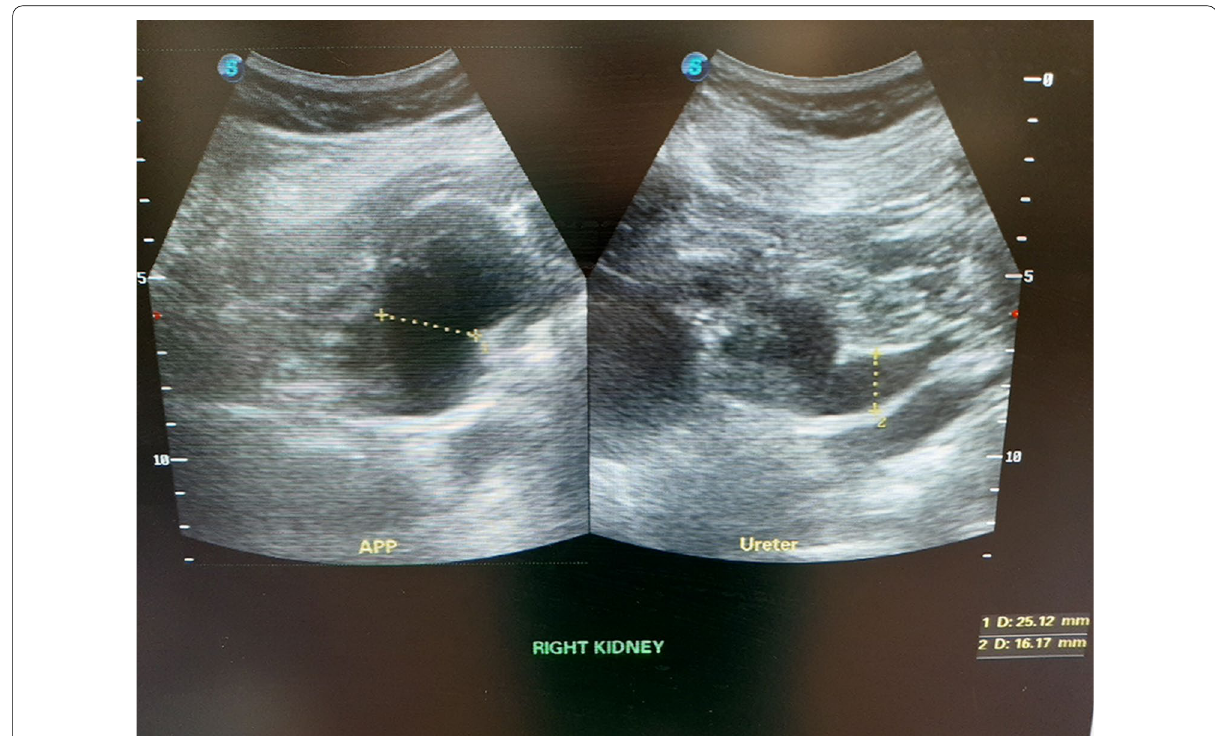
Fig. 1 Ultrasound with right